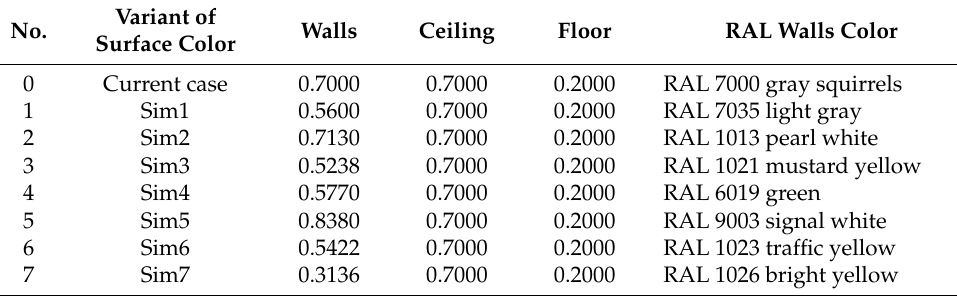
Table 3. Reflection factor for variants of surface